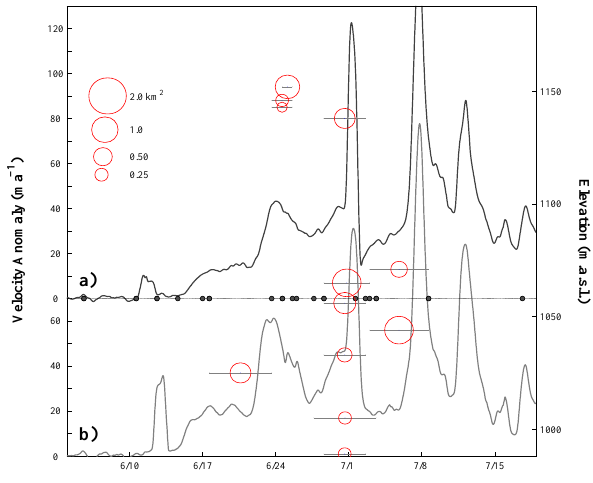
Fig. 6. Surface velocity data from 33N0 (a) and GULL (b) GPS stations for summer 2011, smoothed to 36h resolution and plot- ted as the velocity anomaly relative to the winter baseline at each site. Baseline (0) velocity anomaly (left vertical axis) is positioned at each GPS site’s elevation (right vertical axis). Rapid drainages appear as red circles (see inset scale), plotted at their elevation; horizontal grey bars represent temporal uncertainty (see Sect. 2.5). Black dots along the 33N0 baseline represent images used to define drainage